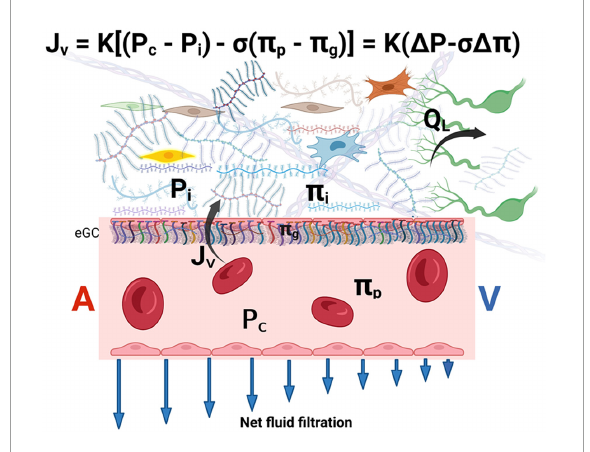
FIGURE2 The revised Starling equation. Microvascular fluid exchange (flow J v ) can be described by the revised Starling equation. The endothelial glycocalyx (eGC) layer modifies the colloid osmotic pressure that opposes filtration from being between the plasma and the interstitium to between π p and π g (where π g << π i ). Blue arrows indicate that net force imbalance and flow diminish along with the length of the capillary from the arterial side ( A ) to the venous side ( V ) of the capillary, but minor filtration prevails even in venules. The interstitial pressure ( P i ) is the main determinant of lymph flow ( Q L ) in the initial lymphatics (see text for details). K is the hydraulic conductance (permeability) of microvascular vessel walls to fluid. σ is the Staverman’s reflection coefficient of the membrane for protein. A and V represent the arterial and venous sides of the capillary, respectively. eGC is the endothelial